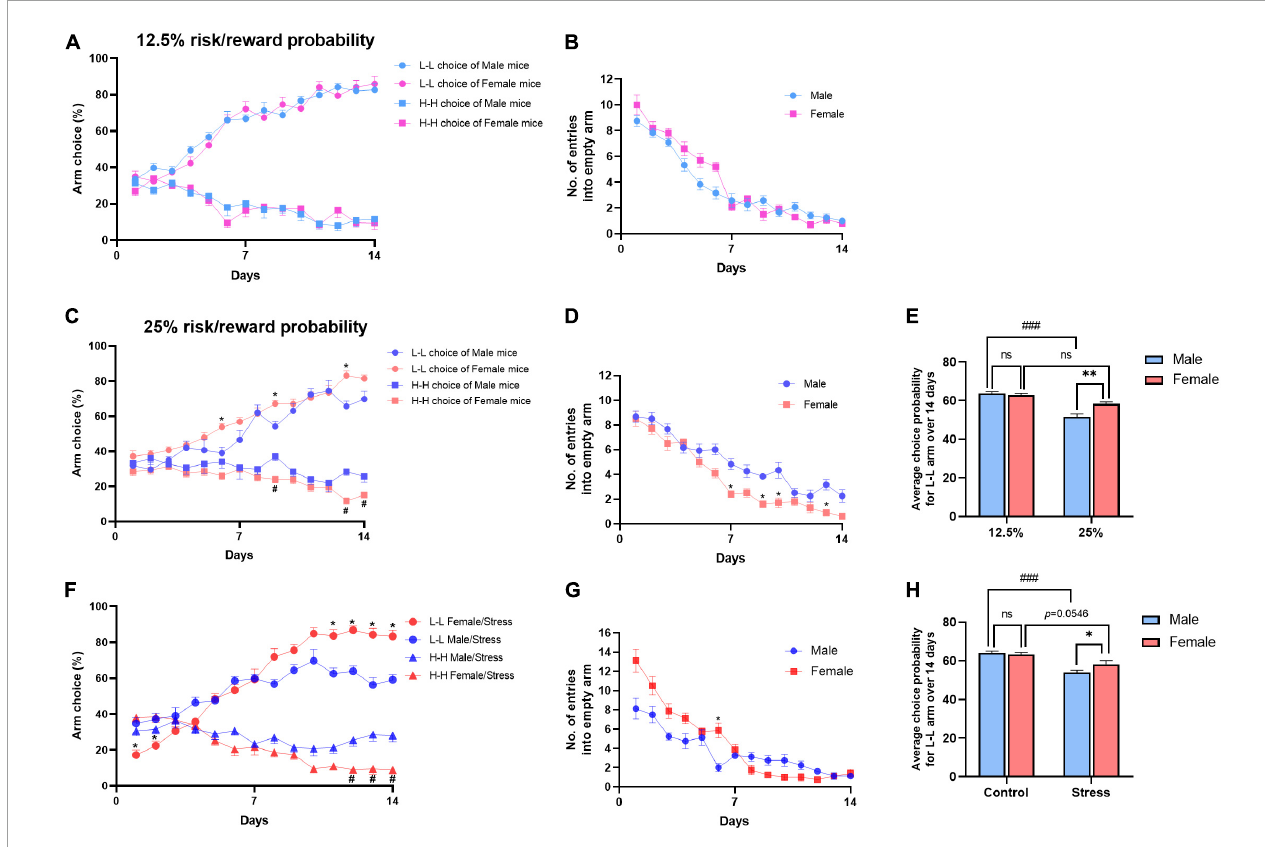
FIGURE4 Differences in decision-making between female and male mice. (A) Performance of different sex mice in the decision-making test under 12.5% probability. (B) Number of entries into empty arms. Not significant [ F ( 1 , 20 ) = 2.454, P = 0.1329]. Dots show choice probability in each session. Repeat ANOVA with Bonferroni correction. Data shown as means ± SEM ( n = 10-12). (C) Performance of different sex mice in the decision-making test under 12.5% probability. Repeated-measures ANOVA with Bonferroni correction. * P < 0.05 vs. the L-L arm choice in male group ( post-hoc Tukey’s test, P = 0.0063 on day 6, P = 0.0057 on day 9, P = 0.0017 on day 13), # P < 0.05 vs. the H-H arm choice in male group ( post-hoc Tukey’s test, P = 0.0019 on day 9, P = 0.0001 on day 13, P = 0.0479 on day 14). (D) Number of entries into empty arms. (E) L-L choice rate acquired over 14 days under the standard or double condition. Values are means ± SEM ( n = 10–12). ** P < 0.01 vs. male group under 25% ratio, ### P < 0.001 vs. male group under 12.5% ratio, n.s., not significant. (F) Performance of different sex mice in the decision-making after stress. Repeat ANOVA with Bonferroni correction. Data shown as means ± SEM (n = 8–12). * P < 0.05 vs. the L-L arm choice in male/stress group ( post-hoc Tukey’s test, P = 0.0067 on day 1, P = 0.0146 on day 2, P = 0.0027 on day 11, P = 0.0002 on day 12, P = 0.0007 on day 13, P = 0.0005 on day 14), # P < 0.05 vs. the H-H arm choice in the male/stress group ( post-hoc Tukey’s test, P = 0.0052 on day 12, P = 0.0052 on day 13, P = 0.0020 on day 14). (G) Number of entries into empty arms after stress. (H) L-L choice rate acquired over 14 days between the control and stress groups. Values are means ± SEM ( n = 8–12). * P < 0.05 vs. stressed male group, ### P < 0.001 vs. control male group, n.s., not